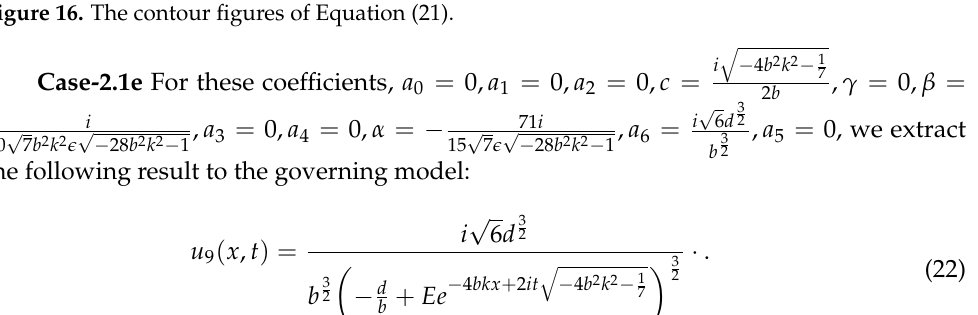
Figure 16. The contour figures of Equation